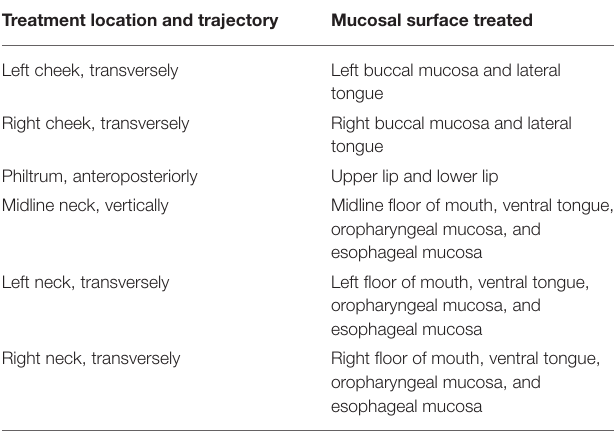
TABLE 1 | Proposed protocol of treatment locations and trajectories and their target mucosal surface for use in extraoral delivery of photobiomodulation therapy for prevention of oral